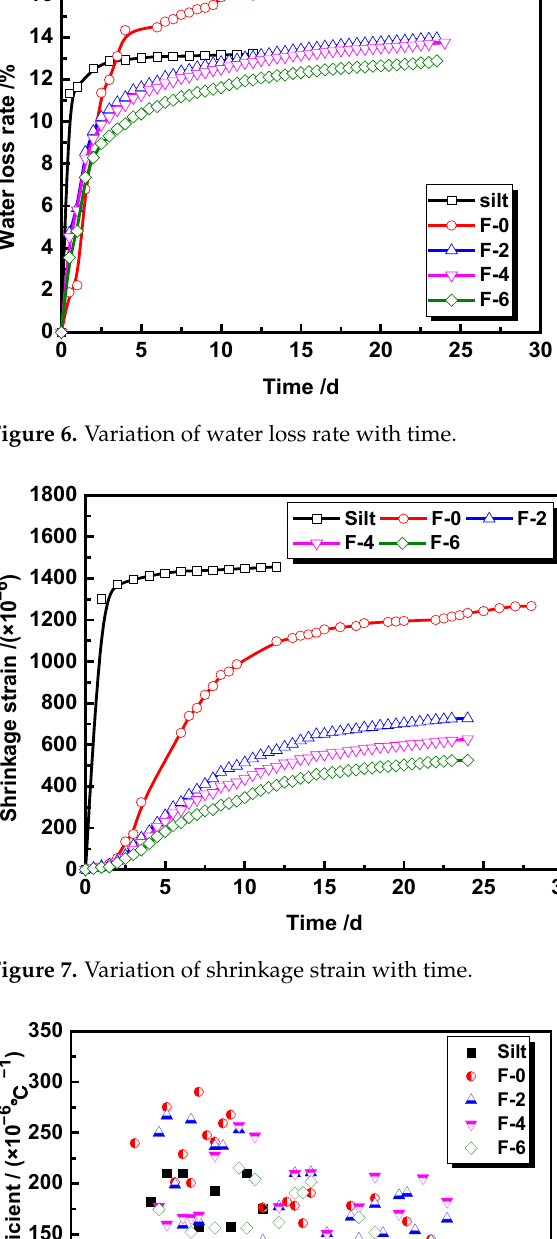
Figure 9. Relationship between water loss rate and dry shrinkage strain. Figure 7 exhibits the shrinkage strain variation of silt and stabilized soil with time. The drying shrinkage of silt develops quickly and diverges from the flexible curing agent stabilized silt at early test ages. The dry shrinkage strain of silt soil mainly occurred in the first day of the dry shrinkage test. the shrinkage strain of silt soil reaches 1302.2 × 10 − 6 με , accounting for 89.5% of its total strain at 12 days. In Figure 7, we observe that the dry shrinkage strain of stabilized silt mainly occurred in the first 14 days, and the flexible cur- ing agent series demonstrate lower drying shrinkage value than silt and cement stabilized silt at early age. The shrinkage strain of F-0 is 1130.8 × 10 − 6 με at 14 test days, accounting for 89.3% of its total strain. The shrinkage strain of F-2, F-4 and F-6 is 634.3 × 10 − 6 με , 535.6 × 10 − 6 με and 443.8 × 10 − 6 με respectively at 14 days, and accounting for 87.3%, 85.4% and 84.4% of their total strain. The incorporation of the flexible curing agent can effectively decrease the shrinkage strain of silt. And the best performance is obtained by the addition 6% curing agent whose drying shrinkage observably decreased and was lowest. Figure 7 exhibits the shrinkage coefficient variation of silt and stabilized soil with time. With the increase of time, the drying shrinkage coefficient shows a change rule that increases first and then stabilizes for all series. The average shrinkage coefficient of silt, F- 0, F-2, F-4 and F-6 is 183.2 × 10 −6 ·°C −1 , 172.1 × 10 −6 ·°C −1 , 171.9 × 10 −6 ·°C −1 , 134.5 × 10 −6 ·°C −1